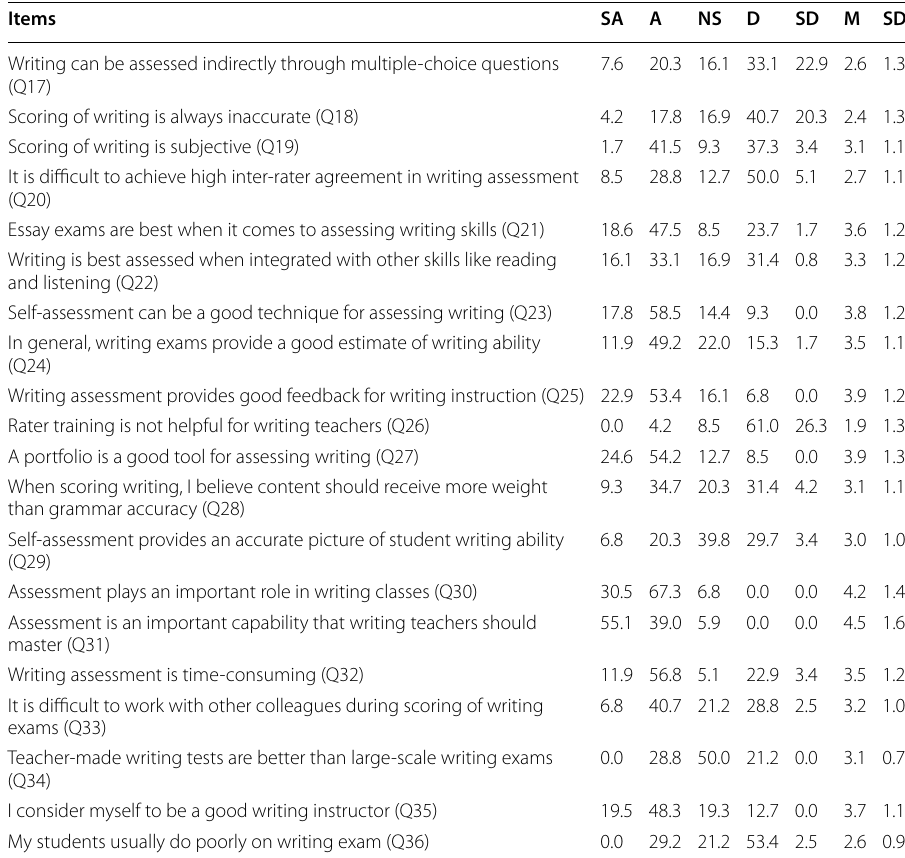
Table 5 Teachers’ beliefs about writing assessment